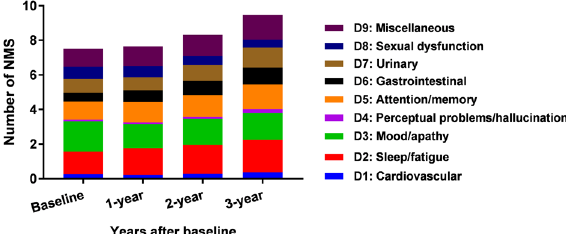
Fig. 1 Number of NMS in patients with PD at each visit. The mean number of NMS in PD increased from 7.5 (SD 4.9) at baseline to 9.5 (SD 5.2) after 3 years. The composition of the number of NMS at each visit was presented in Fig. 1 as well. Increased number of NMS were observed in D1 (mean 0.3 – 0.7), D2 (mean 1.3 – 1.9), D4 (mean 0.1 – 0.2), D5 (mean 1.1 – 1.4), D6 (mean 0.5 – 1.0), D7 (mean 0.8 – 1.2), and D9 (mean 1.0 – 1.4) domains from baseline to 3-year. The number of NMS in the D8 domain was decreased from mean 0.7 at baseline